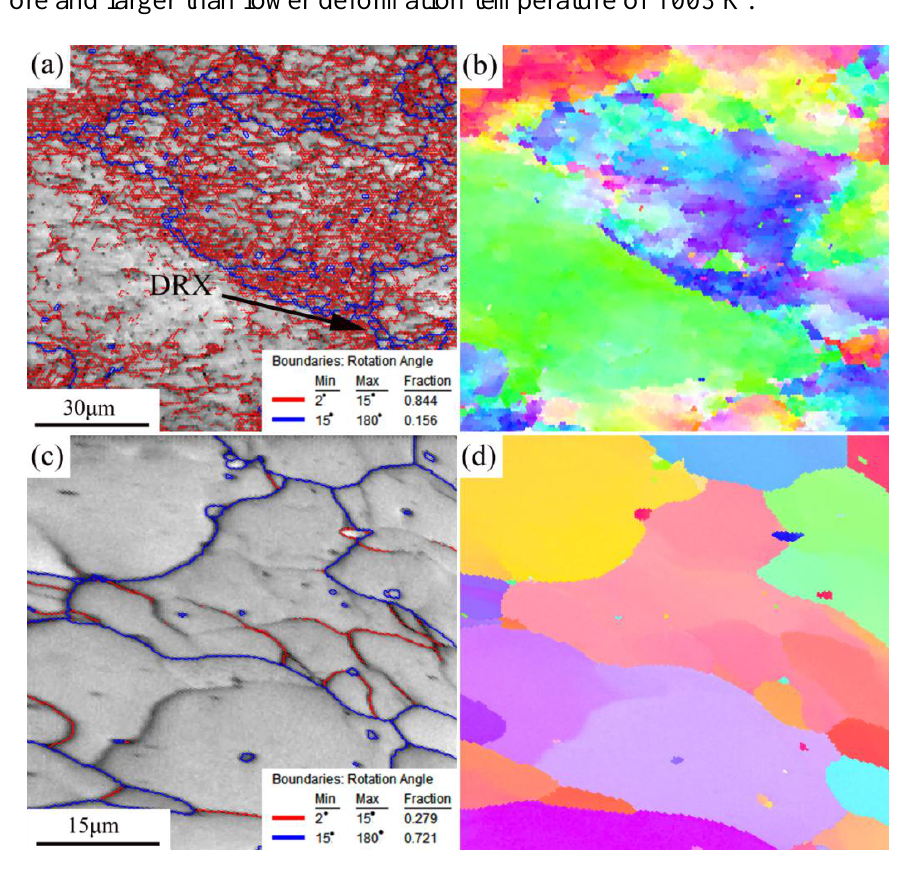
Figure 7. Grain boundary maps and inverse pole figure maps of the alloy deformed at 1078 K with the strain rate of 1 s −1 ( a ), ( b ) and 0.001 s −1 (In a and c ), blue line = HAGBs, green line = LAGBs, DRX = dynamic